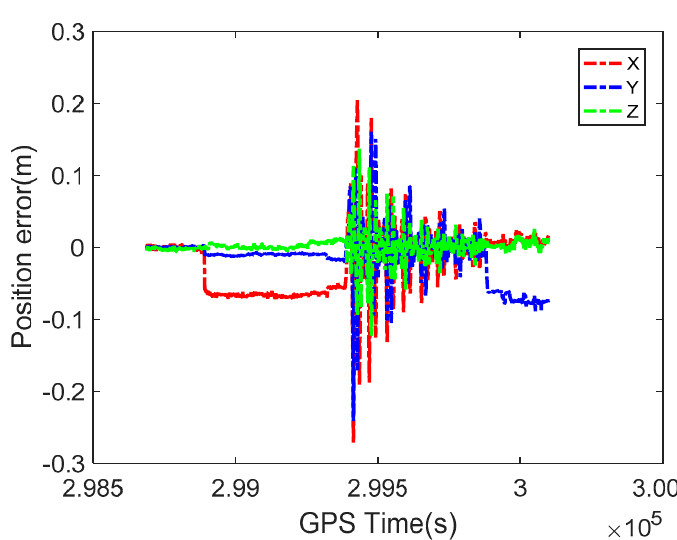
Figure 7. The position error of GPS.